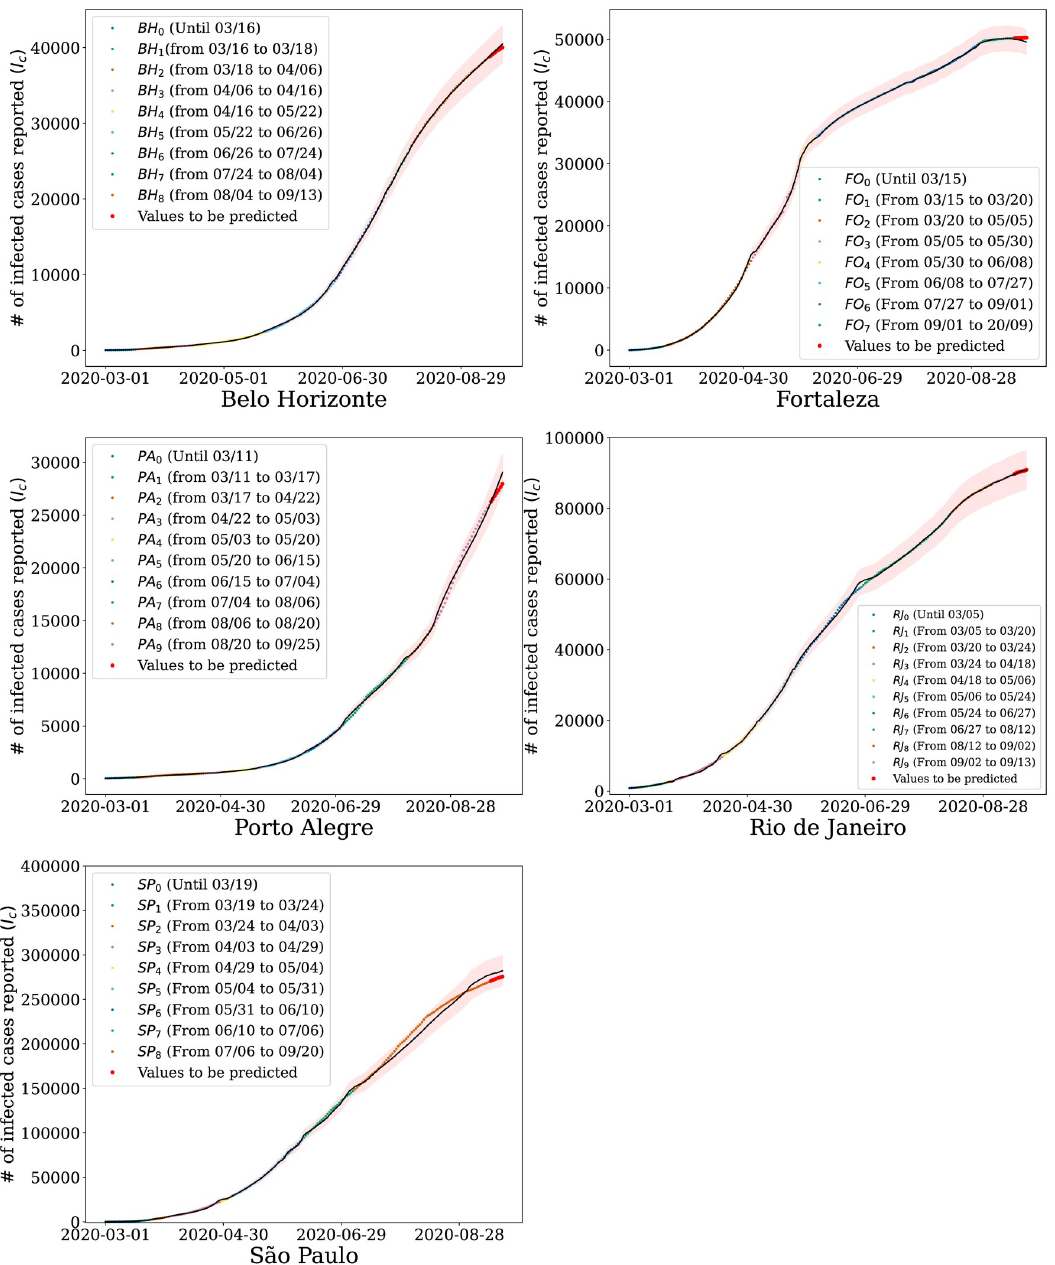
Fig 5. Simulation results for coarse-grained data. Number of infected people estimated by our model for the cities of Belo Horizonte, Porto Alegre, S ã o Paulo, Rio de Janeiro, and Fortaleza when analyzed in the context of Waze mobility indexes. The shaded areas represent the 95% confidence region provided by the model; the black line represents the average model prediction and the points the official values released. (a) Belo Horizonte. (b) Porto Alegre. (c) S ã o Paulo. (d) Rio de Janeiro. (e) Fortaleza.